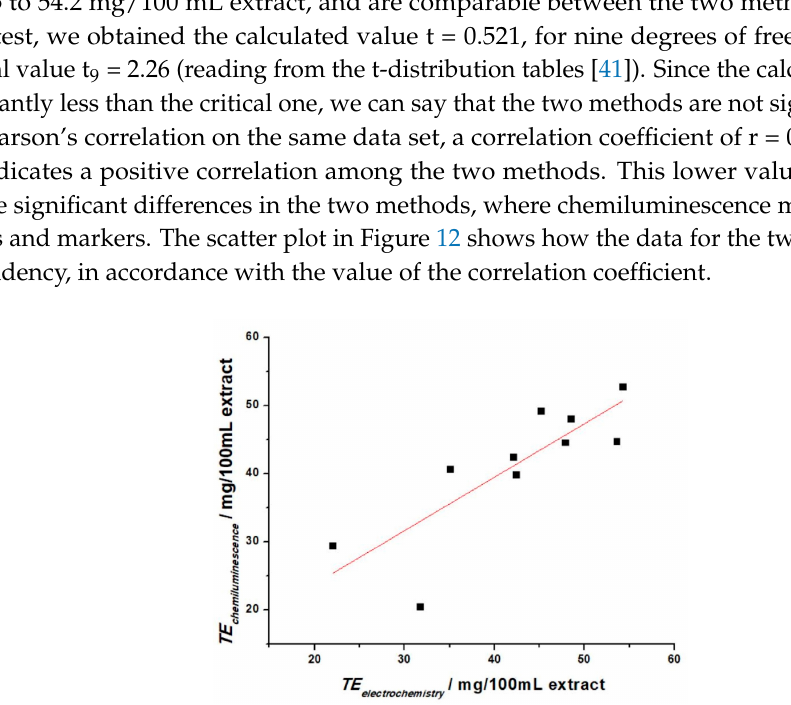
Figure 12. Correlation between electrochemical and chemiluminescence TE values. Correlation coefficient: r = 0.822.